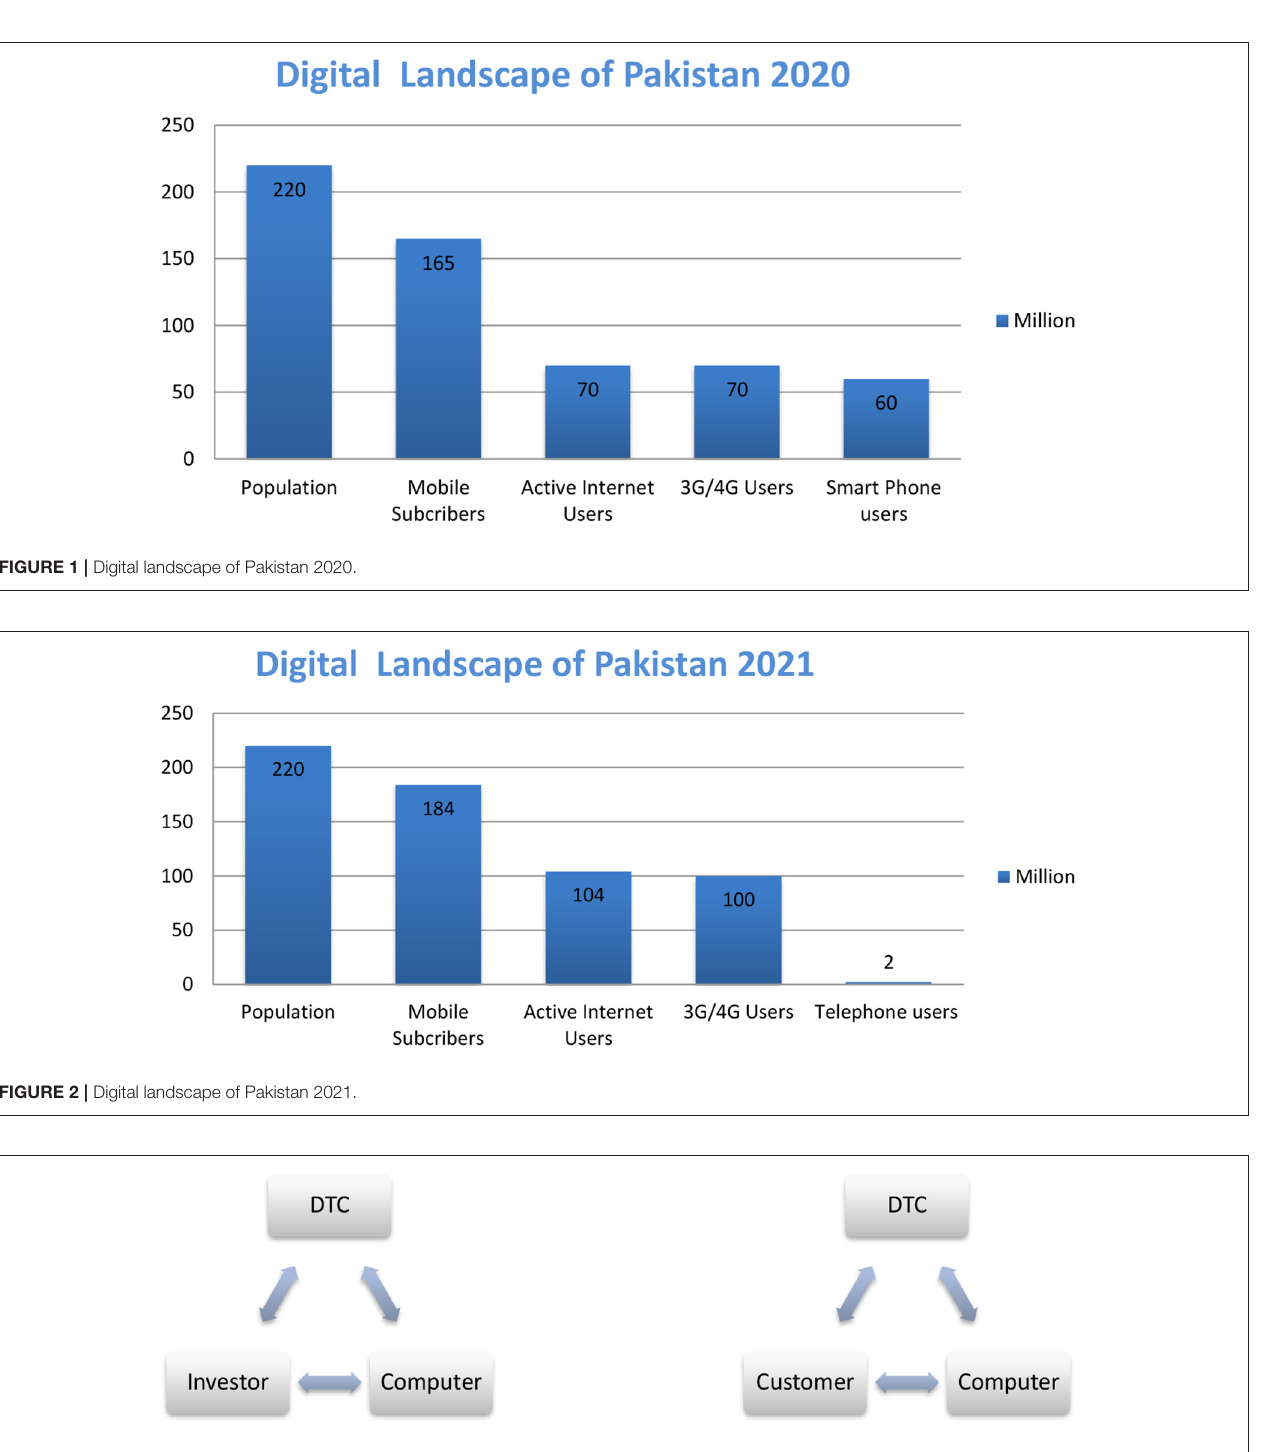
FIGURE 3 | DTC-investors-customers and ICT